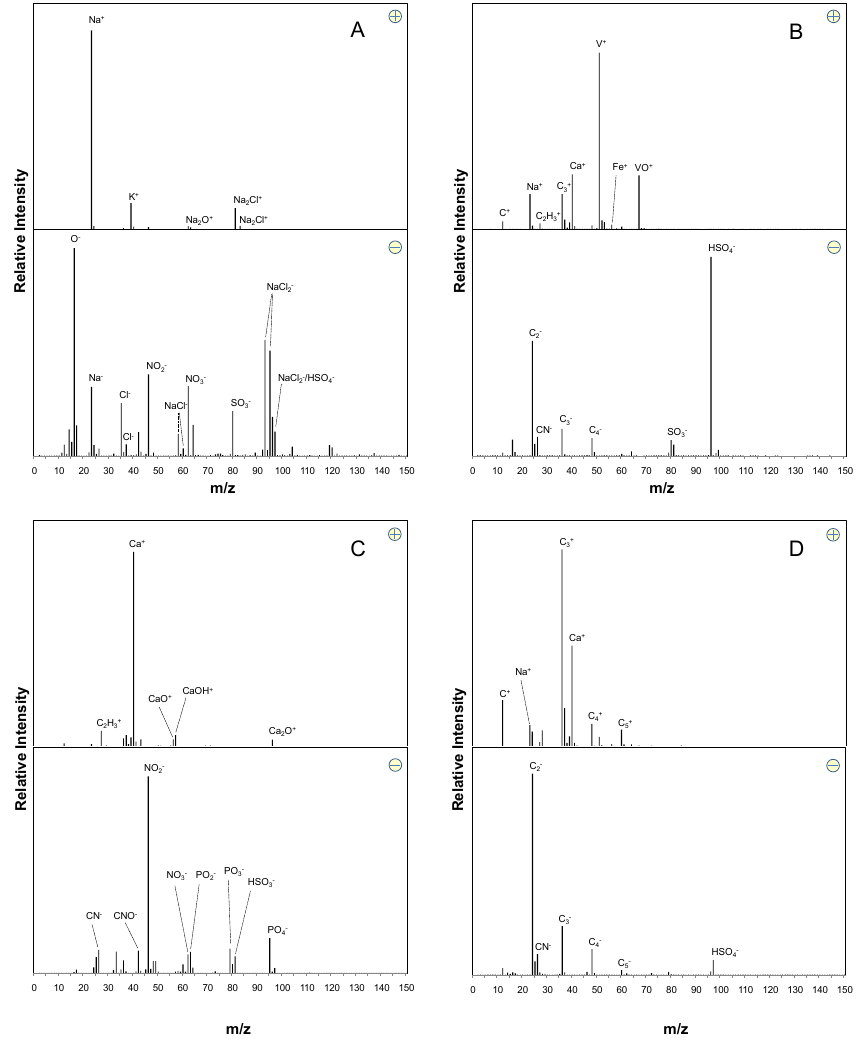
Fig. 10. Average dual ion mass spectra of ATOFMS particle classes; (A) Sea salt, (B) Shipping, (C) Ca-traffic, (D)